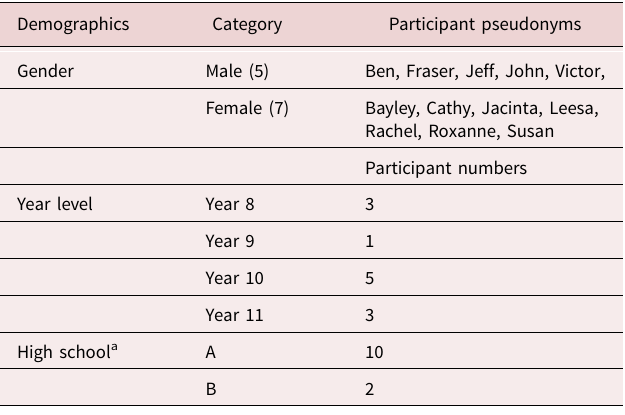
Table 1. Demographics of 12 participating students categorised by gender, year level and school enrolment